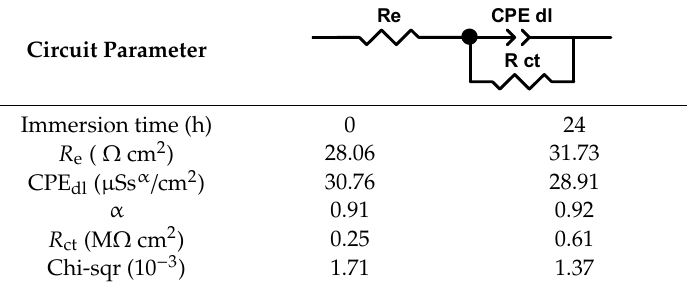
Table 3. Values of the electrical parameter of the equivalent circuit used to fit the spectra of the anodic films for different anodizing times and stirring speeds.